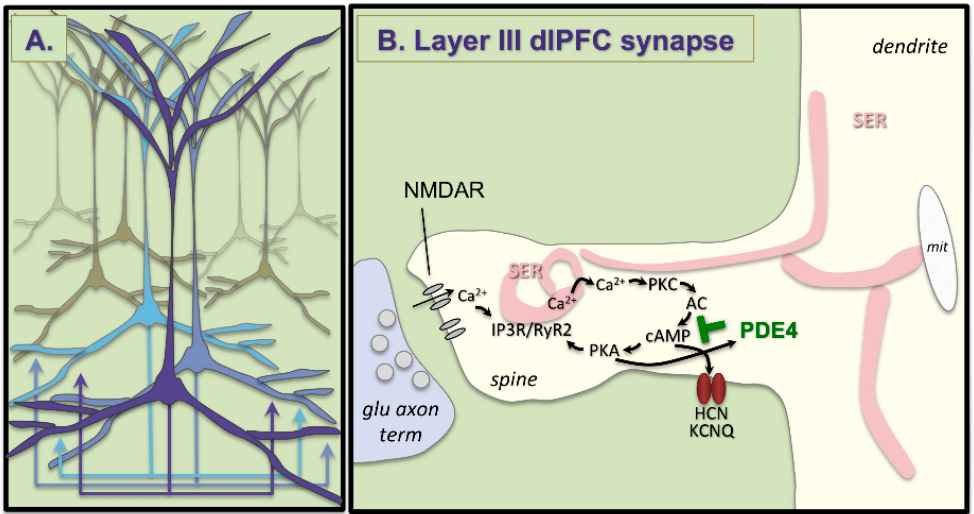
Figure 2. Recurrent excitation in deep layer III of the dlPFC. ( A ) Schematic drawing of clusters of pyramidal cells in deep layer III of dlPFC with shared characteristics that excite each other through extensive recurrent excitatory glutamatergic connections to keep information “in mind” in the absence of sensory stimulation. ( B ) A glutamate synapse on a pyramidal cell spine in deep layer III of dlPFC. These synapses depend on NMDAR stimulation, and have extensive elaboration of the calcium-containing smooth endoplasmic reticulum (SER) “spine apparatus” in the spine, where there is evidence of feedforward calcium-cAMP signaling, which can open HCN and KCNQ channels to reduce firing. This process is held in check by the phosphodiesterases (PDE4), which catabolize cAMP and are anchored to the spine apparatus by DISC1 [56].